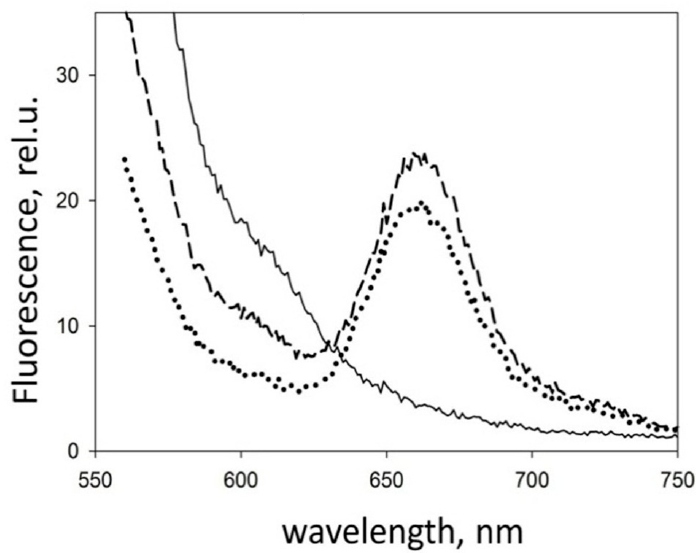
Figure 3. Fluorescence of a droplet of a peptide solution on the glass surface with excitation at 513 nm. A peptide labeled only with Cy3 is a solid line. A mixture of peptides marked Cy3 and Cy5 is a dashed line. The fluorescence of a glass surface gently washed after measuring the mix of peptides is a dotted line.